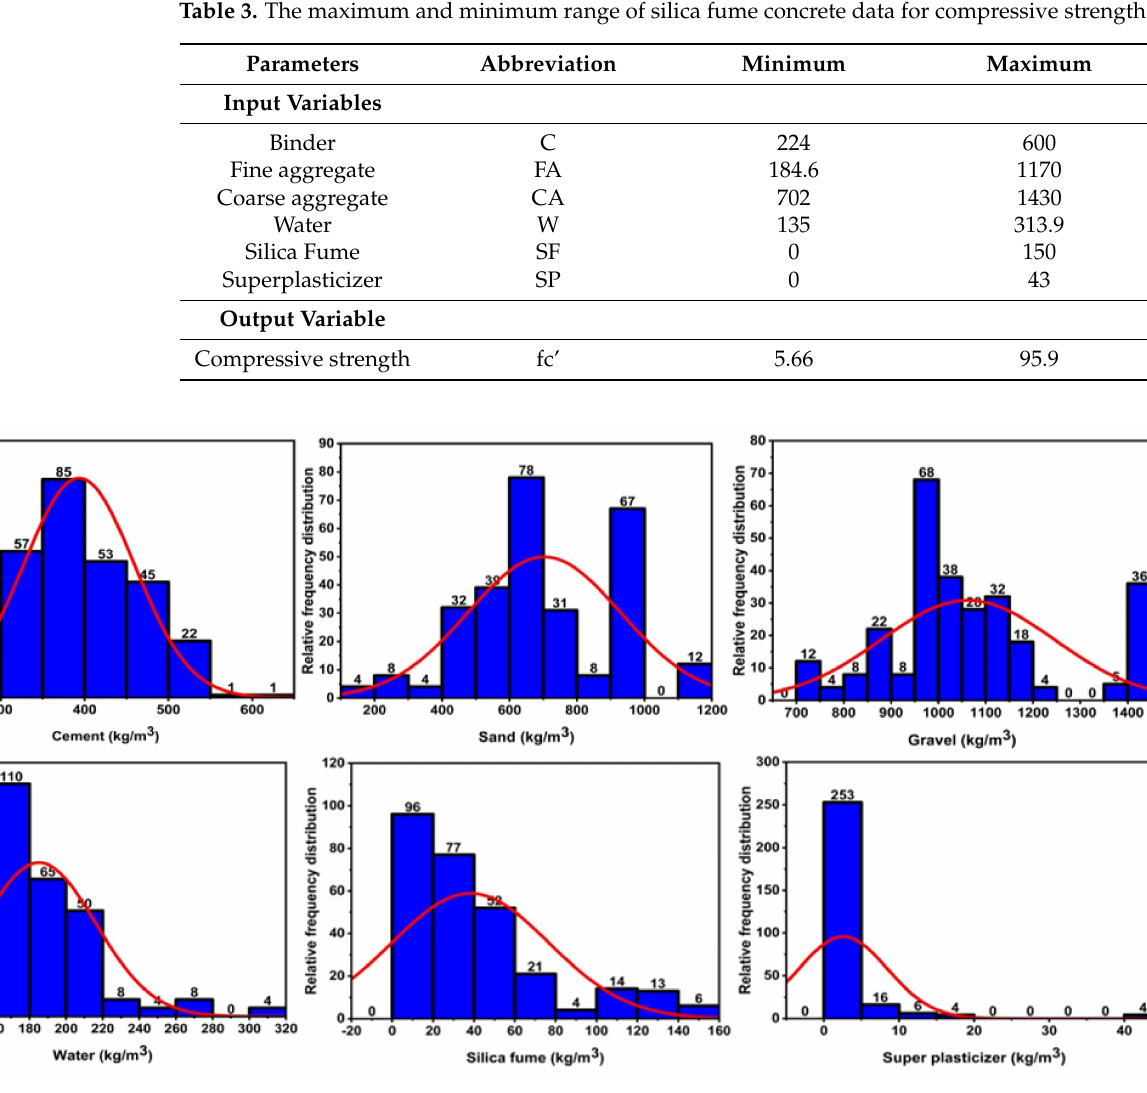
Figure 5. Relative frequency distribution of parameters to compressive strength; cement, sand, gravel, water, silica fume, and super